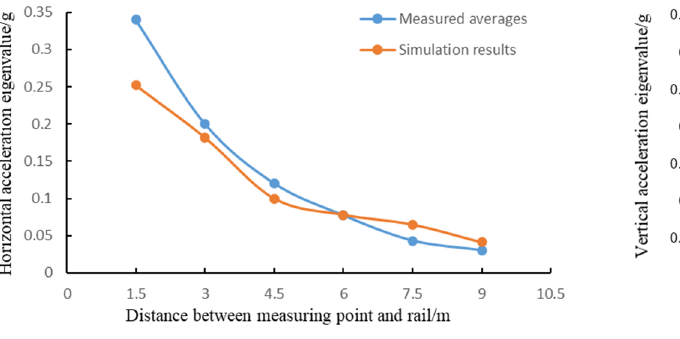
Figure 11. Acceleration change curve of each measuring point of the fully load train. ( a ) Horizontal acceleration change curve of each measuring point of the fully load train; ( b ) vertical acceleration change curve of each measuring point of the fully load train.